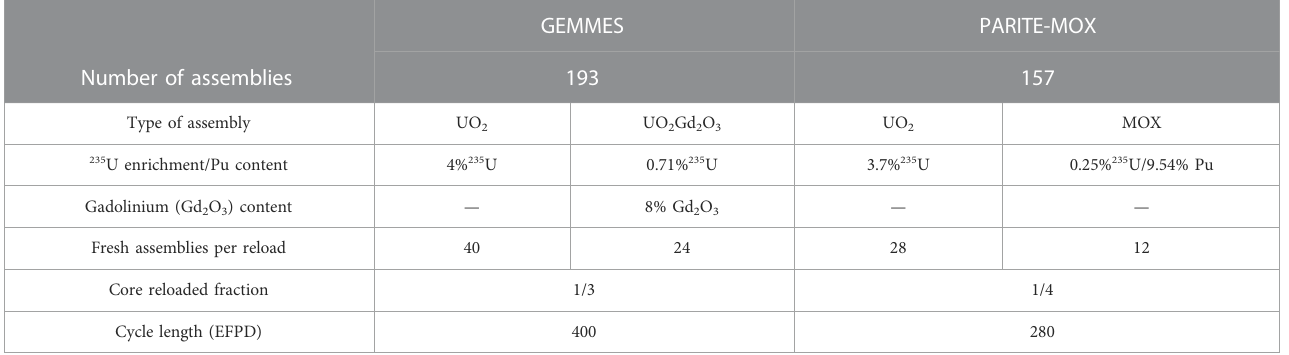
TABLE 2 General data on GEMMES and PARITE-MOX fuel management.